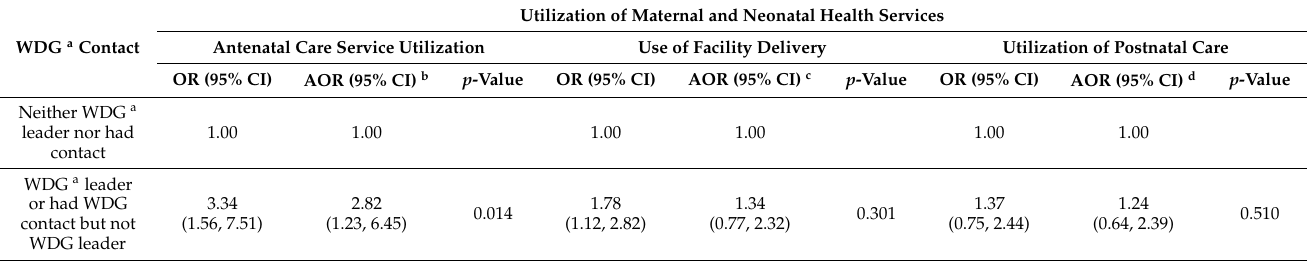
Table 3. Association of WDG contact with utilization of maternal and neonatal health services in Ethiopia,